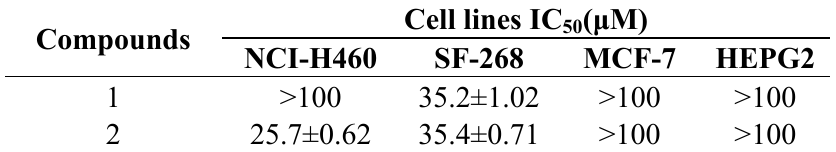
Table 1. In vitro cytotoxic activity of compounds 1 and 2 on cancer cell lines a . Compounds